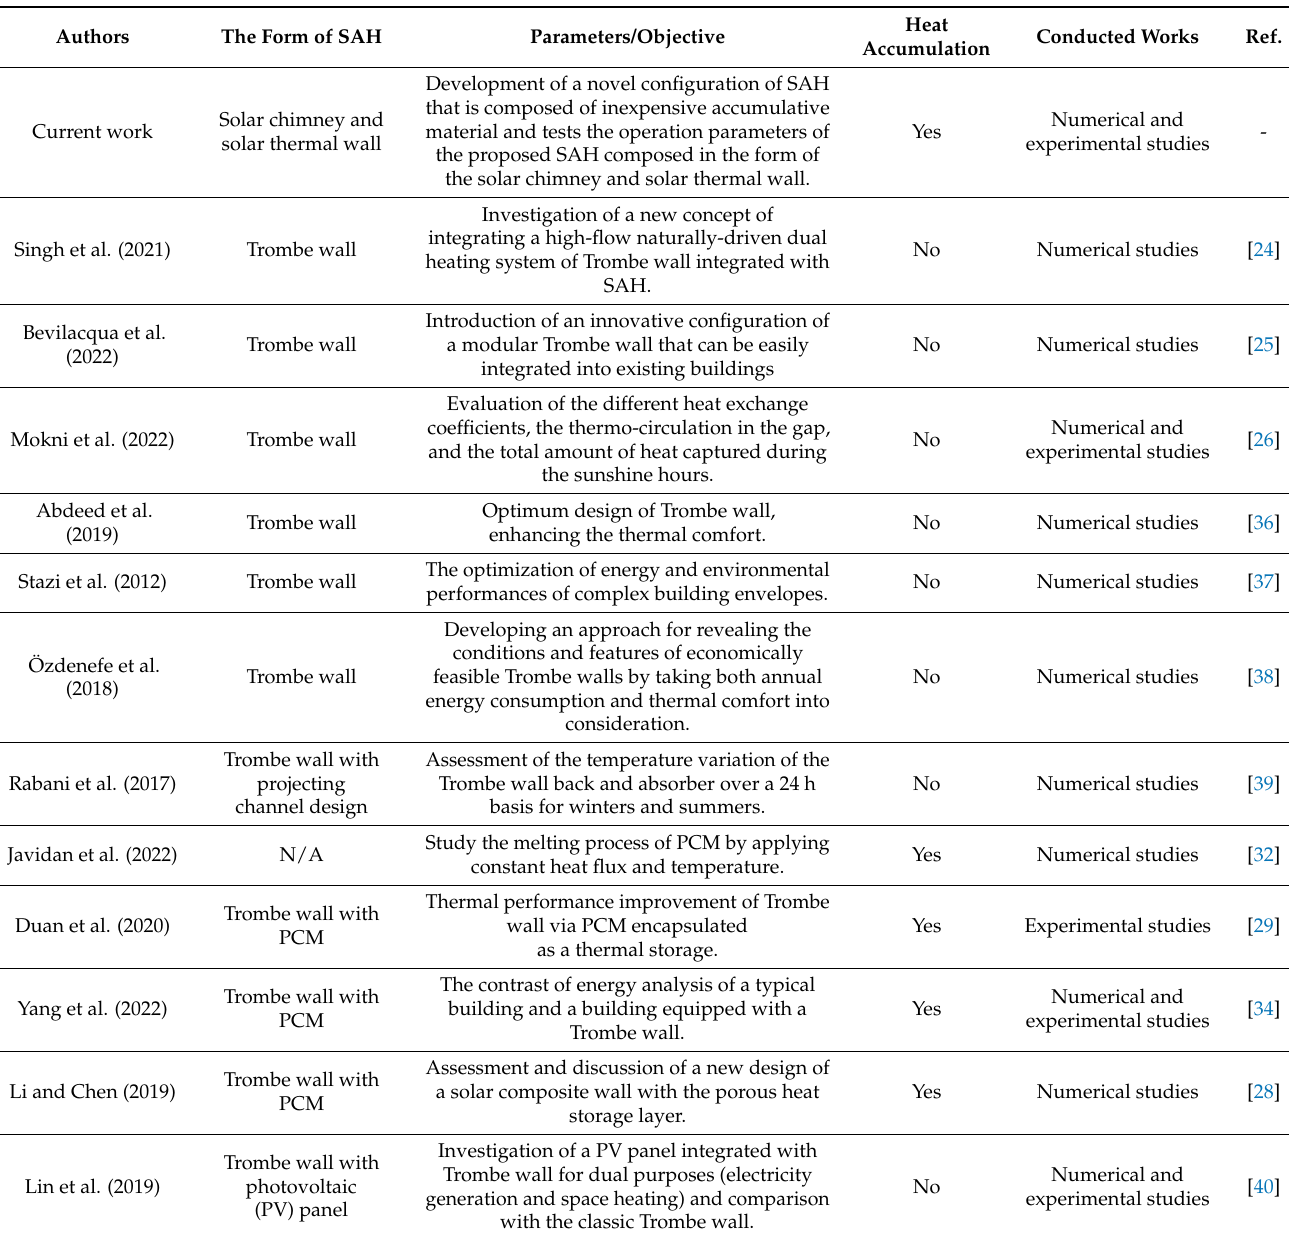
Table 2. The comparison between the proposed SAH and SHS systems available in the